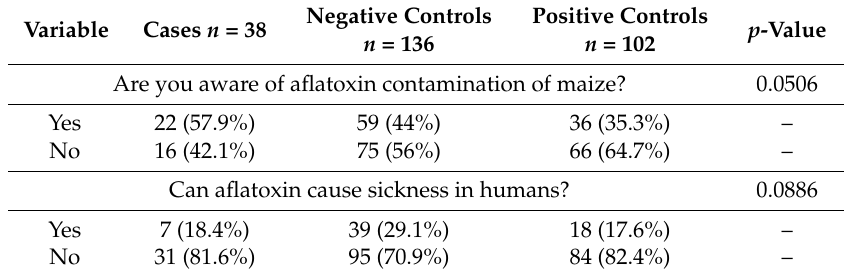
Table 5. Logistic Models of probability of being a case given food consumption habits and awareness of aflatoxin. Variable Case vs. All Controls *